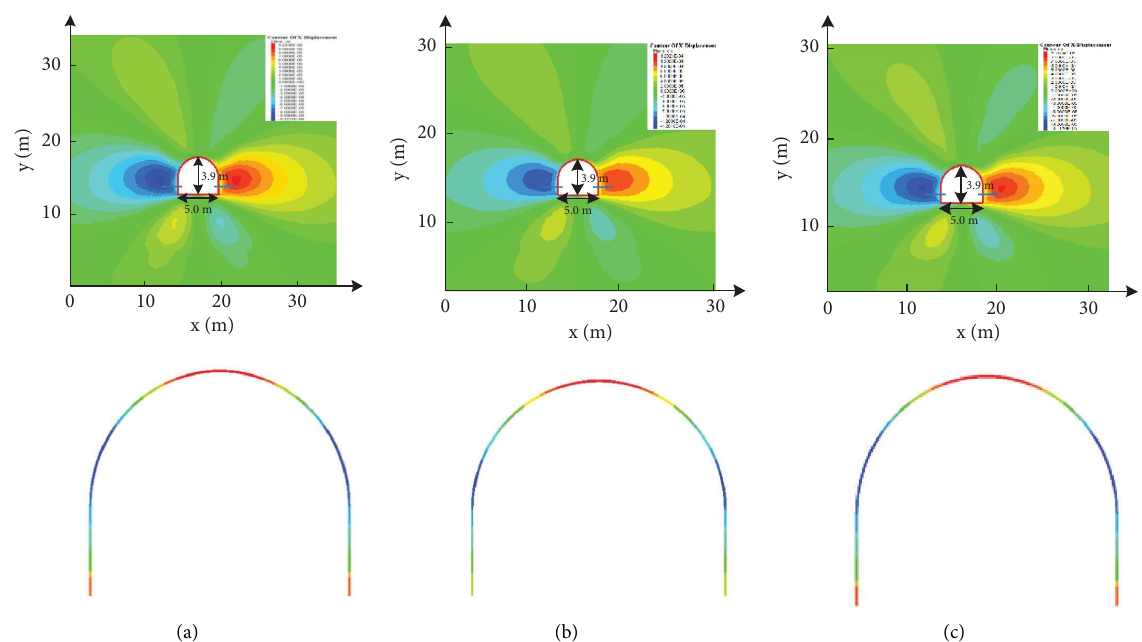
Figure 10: Horizontal displacement. (a) Scheme 1. (b) Scheme 2. (c) Scheme